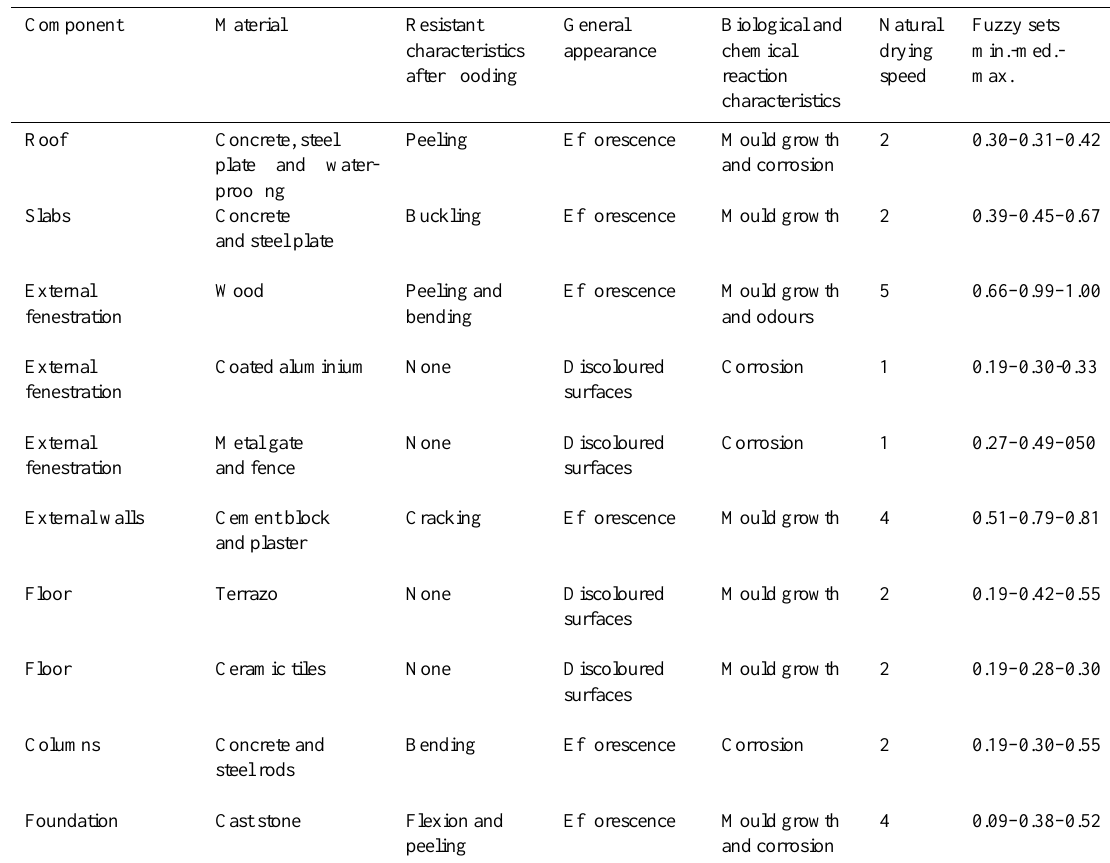
Table 2. Qualification of attributes of susceptibility. Component Material Resistant